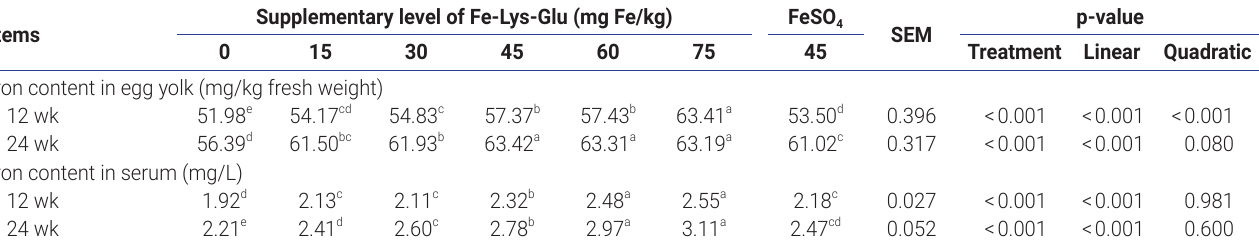
Table 4. Effects of dietary Fe-Lys-Glu supplementation on the concentrations of iron in egg yolk and serum Items